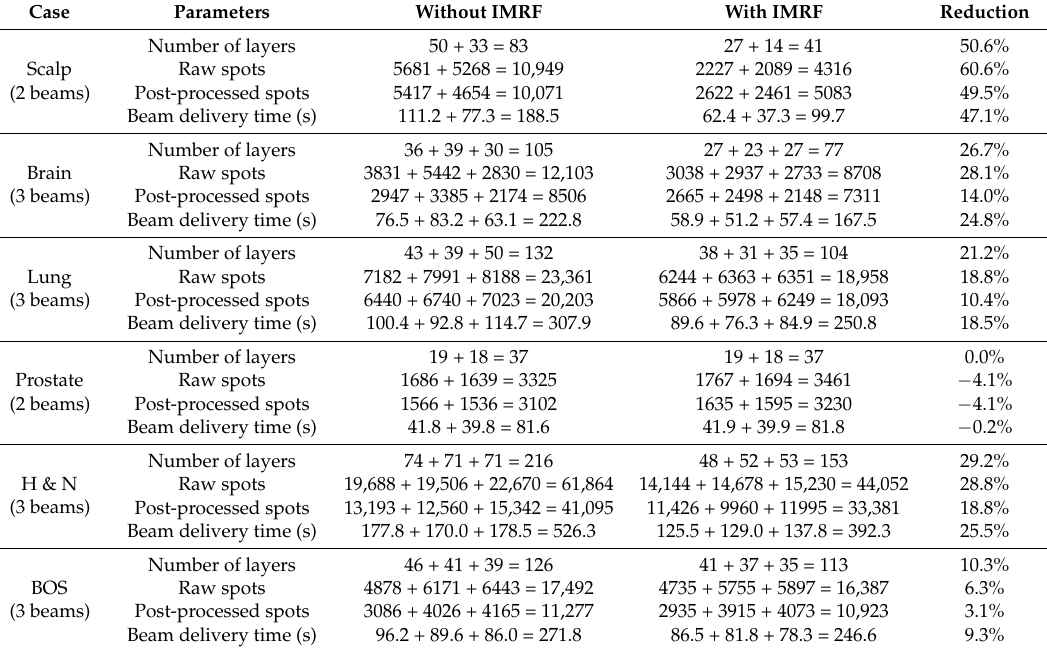
Table 3. Beam lines and beam delivery times for plans without and with integrated mini-ridge filter